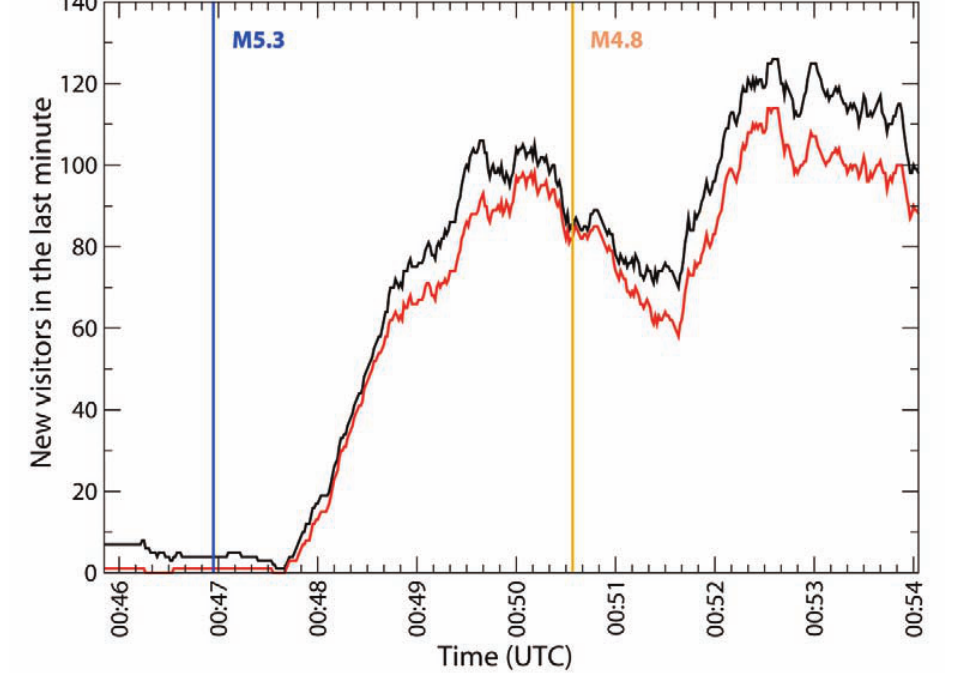
Figure 10 . Website traffic surge as a result of two co-located earthquakes of M 5.3 and M 4.8 that occurred 3 min and 30 s apart in the Patras region (Greece) on January 22, 2010. The black curve shows the number of new website visitors in the last minute; the red curve shows the new website visitors originating from Greece, i.e. the country where the event was felt. While both shocks are clearly visible, the automatic detection of the second shock by seismological networks proved tricky, as its seismic waves were mixed with the waves of the mainshock. These shocks happened at about 03:00 local time, and the increase in the number of visitors from Greece is clearly visible within less than 50 s of the earthquake occurrence. Geographic filtering (red curve) improves the signal-to-noise ratio and can lead to faster detection of website traffic